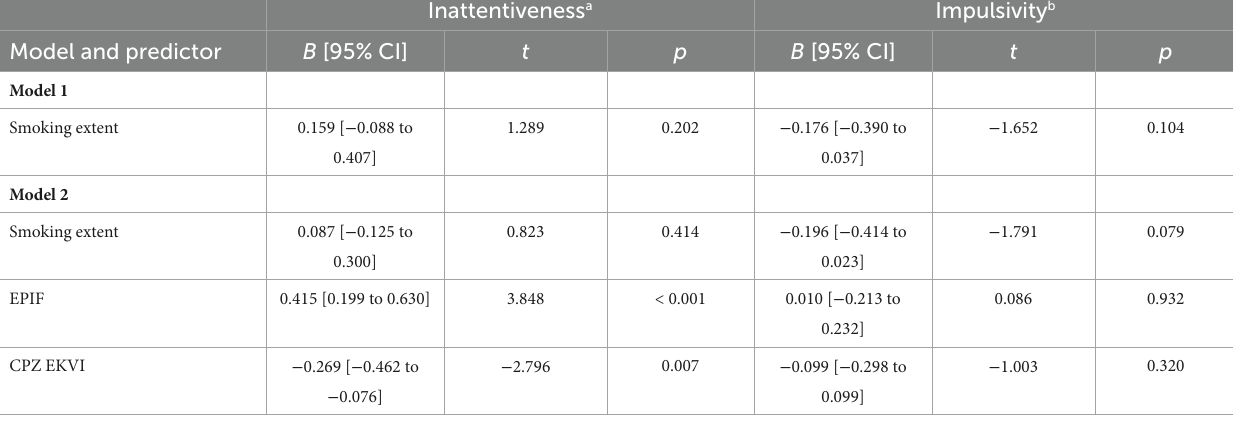
TABLE 4 Among smokers with SSDs ( N = 61), cigarette smoking extent and CPT component scores were not significantly